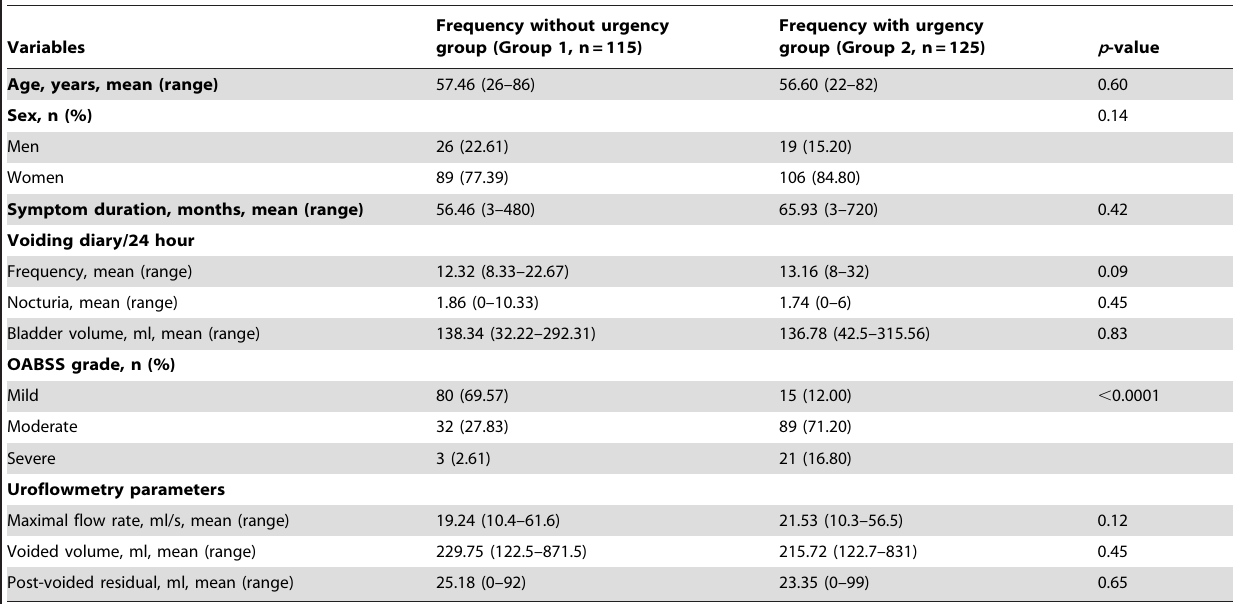
Table 1. Demographics and baseline characteristics.